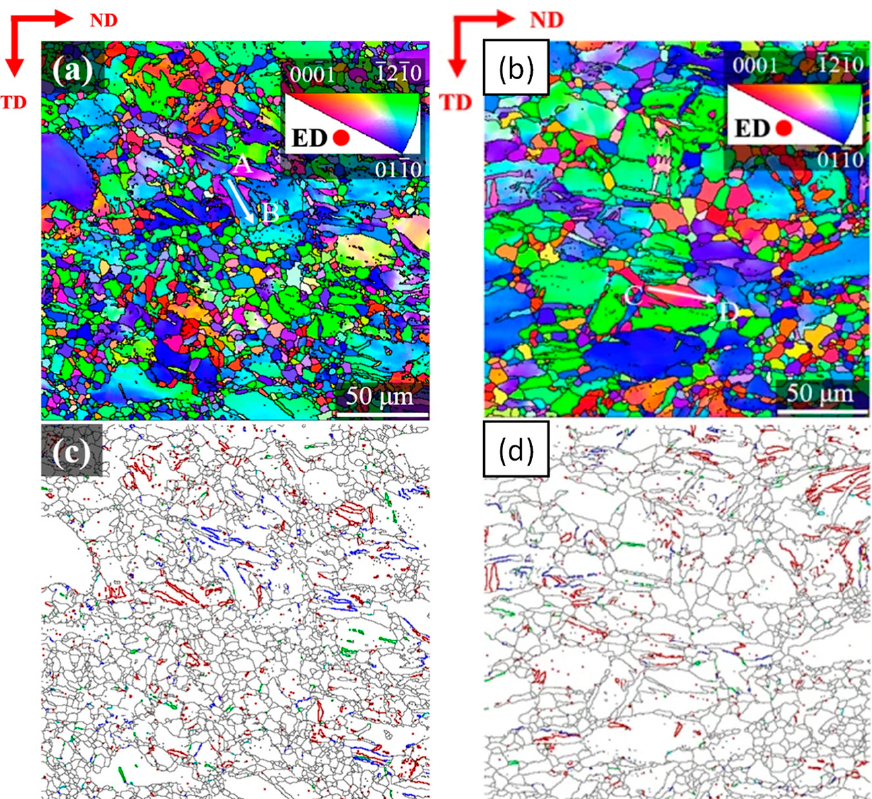
Figure 25. EBSD map and twin distribution map at different temperatures [27]: ( a , c ) 250 °C; ( b , d ) 300 °C. Reproduced with permission from Springer Nature.